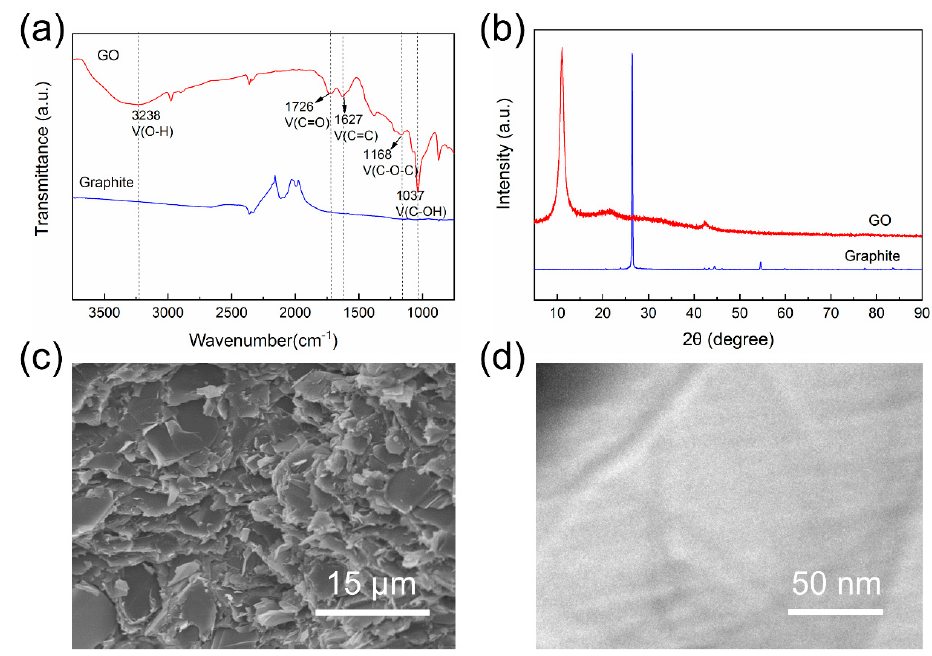
Figure 2. ( a ) FTIR spectra of graphite and graphene oxide (GO). ( b ) XRD patterns of graphite and GO. ( c ) SEM image of graphite flakes. ( d ) TEM image of GO.